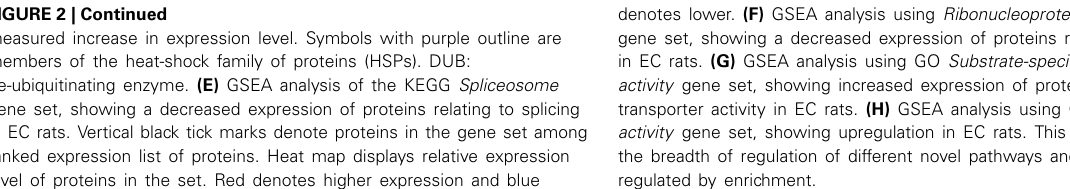
FIGURE 2 | Continued measured increase in expression level. Symbols with purple outline are members of the heat-shock family of proteins (HSPs). DUB: de-ubiquitinating enzyme. (E) GSEA analysis of the KEGG Spliceosome gene set, showing a decreased expression of proteins relating to splicing in EC rats. Vertical black tick marks denote proteins in the gene set among ranked expression list of proteins. Heat map displays relative expression level of proteins in the set. Red denotes higher expression and blue